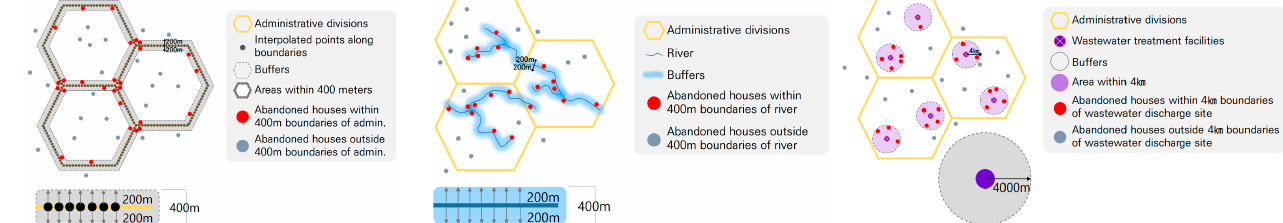
Figure 6. Method of data construction and measurement.